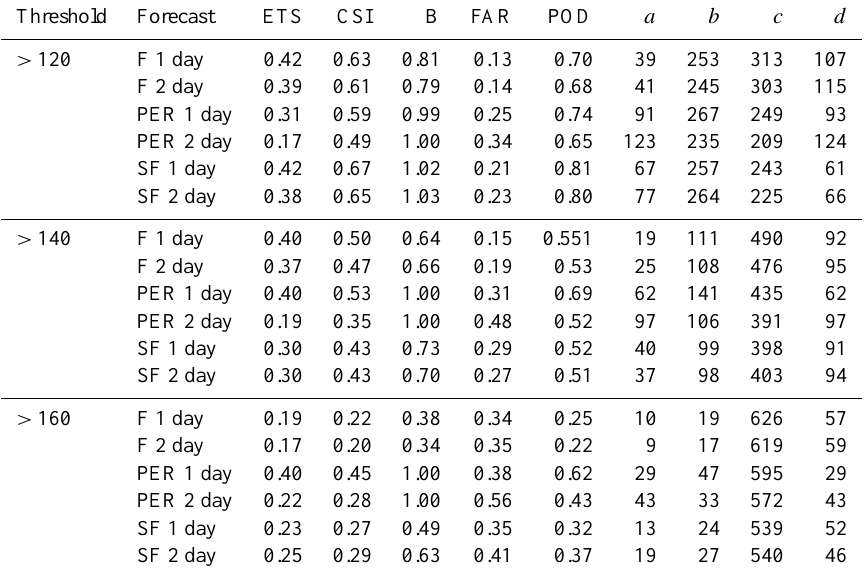
Table 5. Categorical evaluation of 1h daily maximum ozone predictions for different thresholds, calculated for eight monitoring sites with available statistical